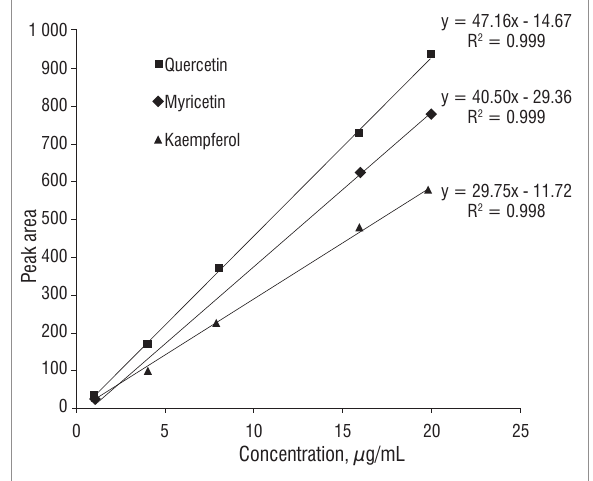
Table 1: Concentration of flavonols (mg/kg dry matter) in Moringa oleifera and selected vegetable samples Sample